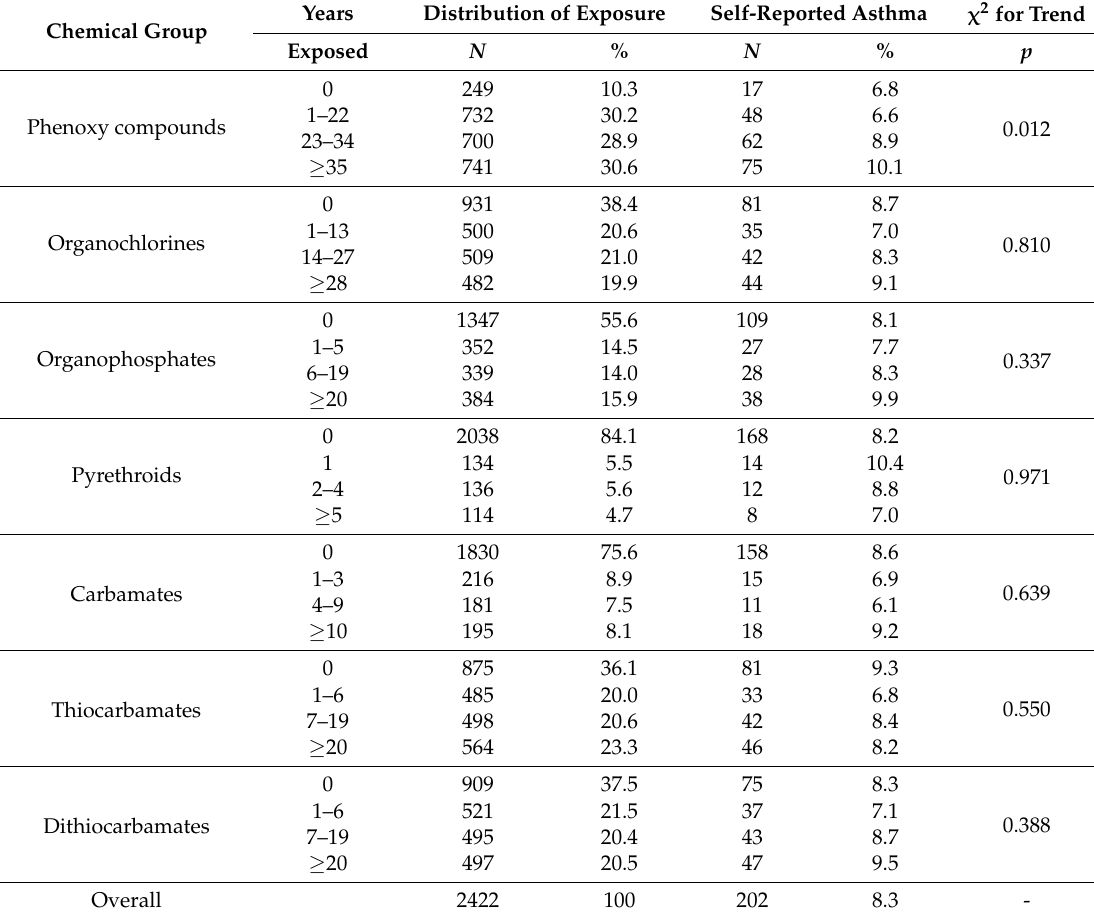
Table 2. Estimated duration of exposure by chemical group and self-reported asthma.